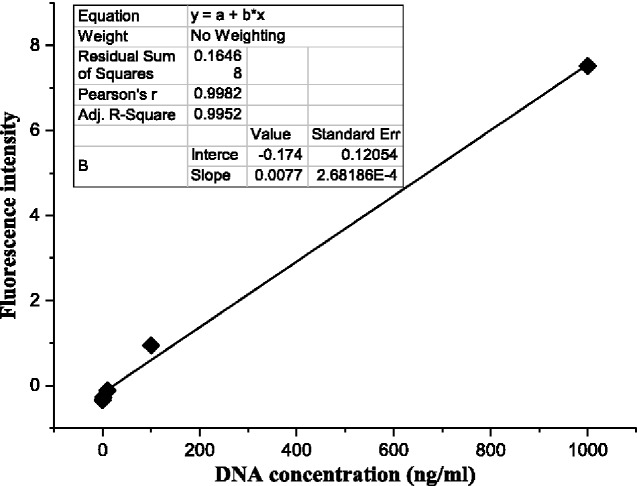
DNA standard curve.